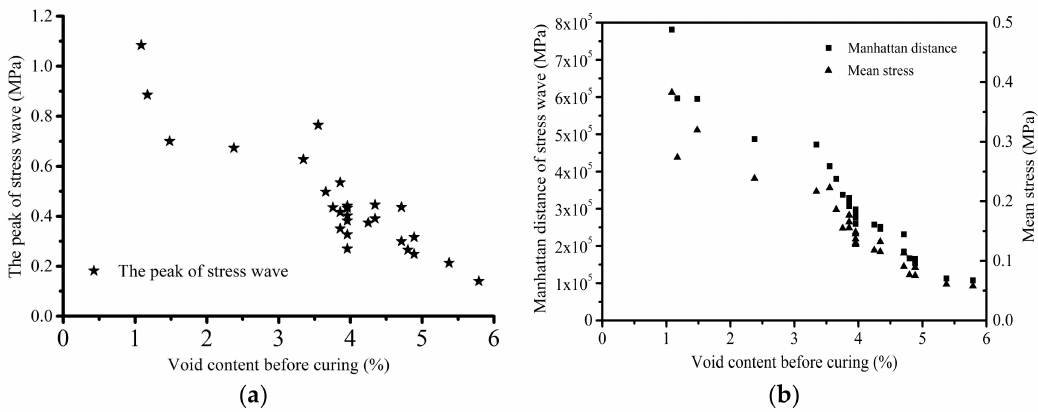
Figure 14. The relationship between the void content and the characteristics of stress wave during the laying process: ( a ) the peak; and ( b ) the Manhattan distance and mean